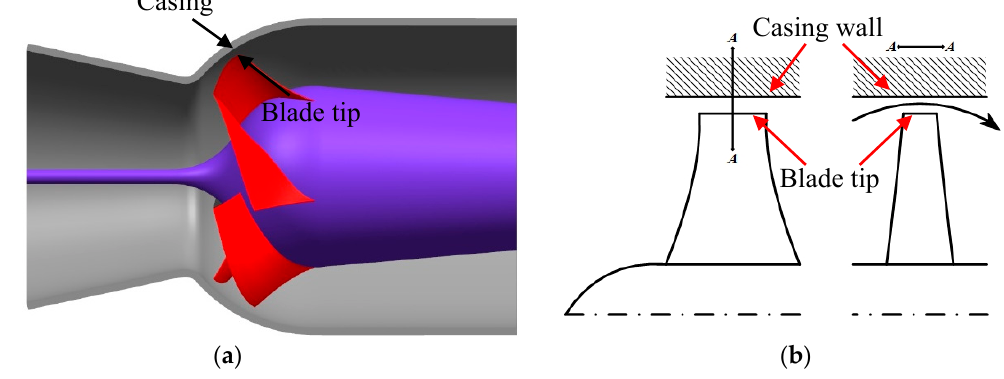
Figure 1. Tip clearance between blade tip and casing wall. ( a ) Three dimensional perspective; ( b ) two dimensional perspective. Table 1. Examples of performance change in pump under the influence of tip clearance.